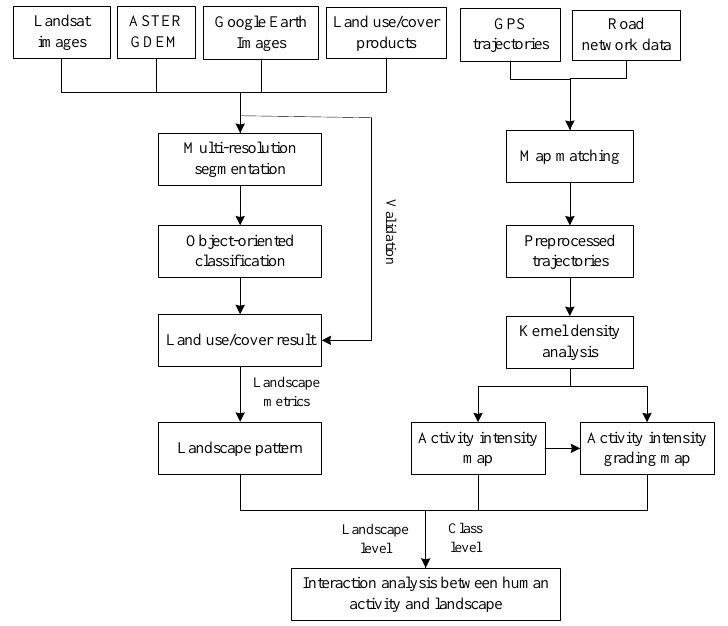
Figure 4. Flowchart of the interaction analysis between human activity and landscape.